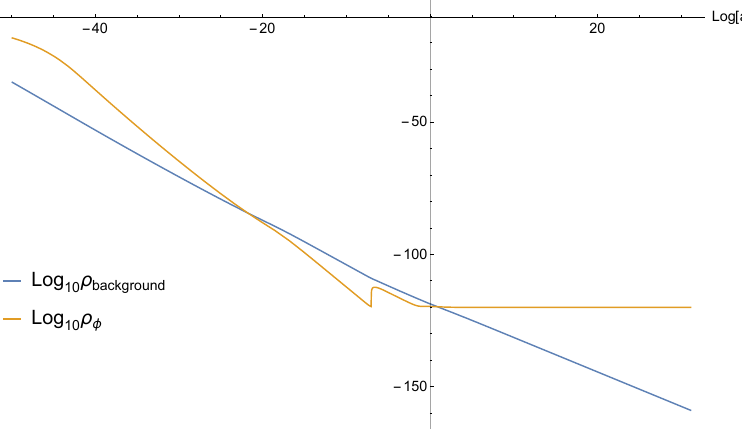
Figure 3. Log-log plot of the energy density of the scalar field in Planck units (orange) and that of the background (blue) after the end of inflation. Originally, the scalar field kinetic density dominates (kination) until the moment of reheating when the background density takes over. The scalar field momentarily freezes at equality, but then unfreezes in the matter era, due to the background backreaction. Eventually, it comes to dominate at